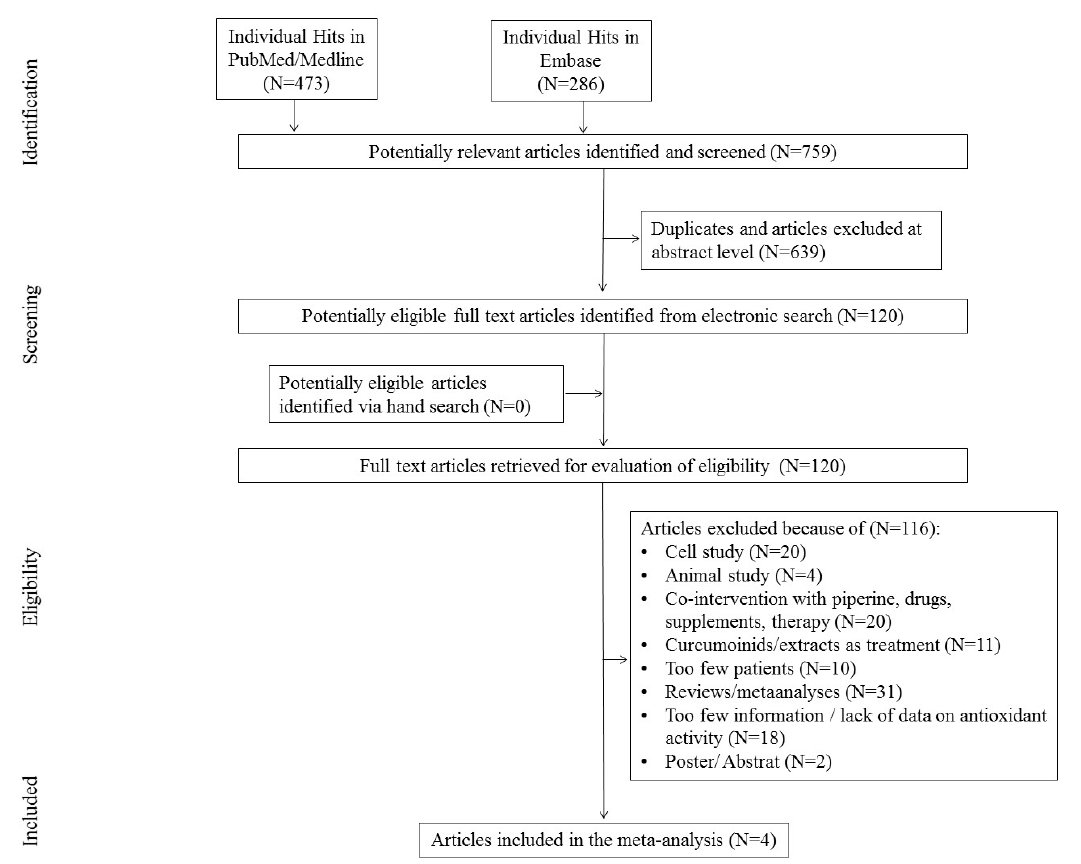
Figure 1. Study flow chart.